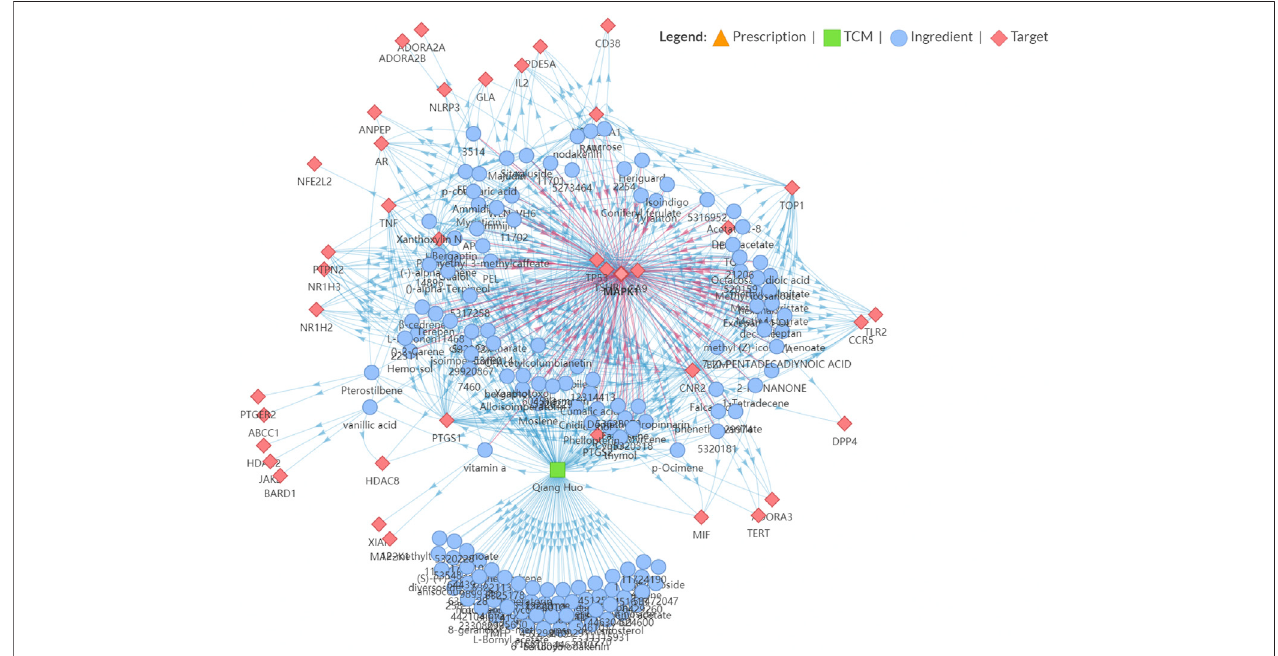
FIGURE 3 | Snapshot of Hansenia weberbaueriana – ingredient – target network related to Immuno-Oncology (IO).